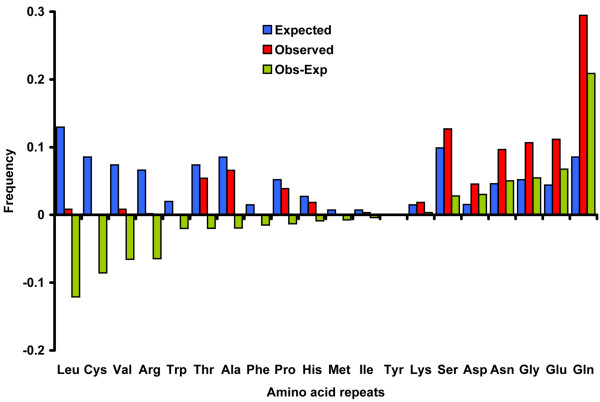
The predicted and observed frequencies of amino acid repeats encoded by tri-nucleotide SSRs. Predicted (blue bars) and observed (red bars) frequencies for each amino acid repeat are presented. Green bars represent the differences between the predicted and observed frequencies for each amino acid repeat. If the expected frequency is higher than the observed frequency, the green bar is drawn below the x-axis. If the observed frequency is higher than the expected frequency, the green bar is drawn above the x-axis. Please see Methods and main text for more detailed description.